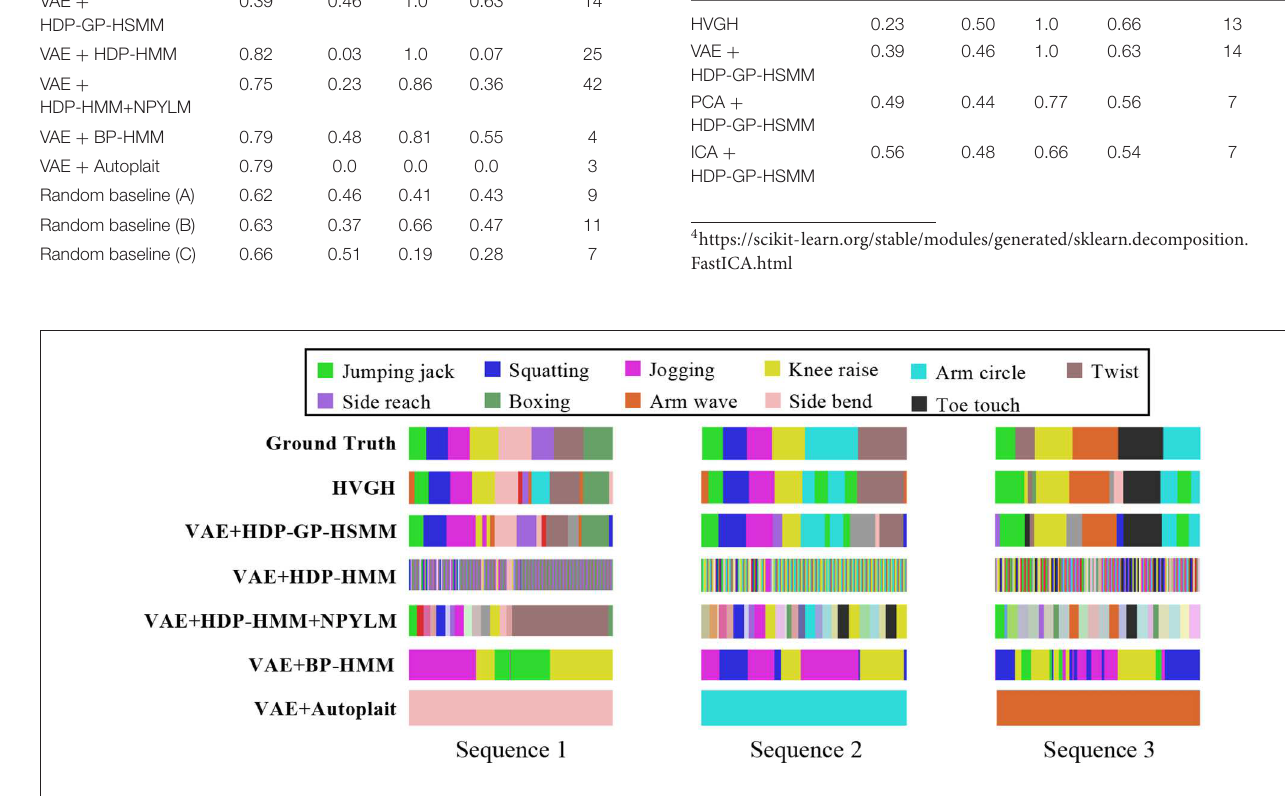
FIGURE 17 | Segmentation results for exercise motion